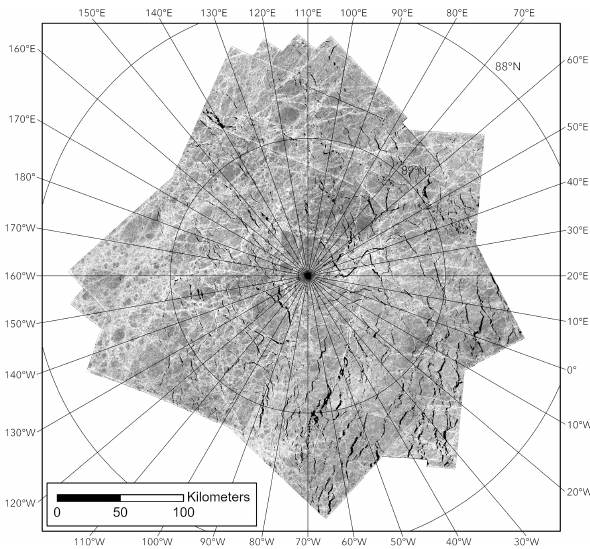
Figure 4. RCM image coverage over the North Pole on 15 Septem- ber 2020. RADARSAT Constellation Mission imagery © Govern- ment of Canada 2020. RADARSAT is an official mark of the Cana- dian Space Agency.